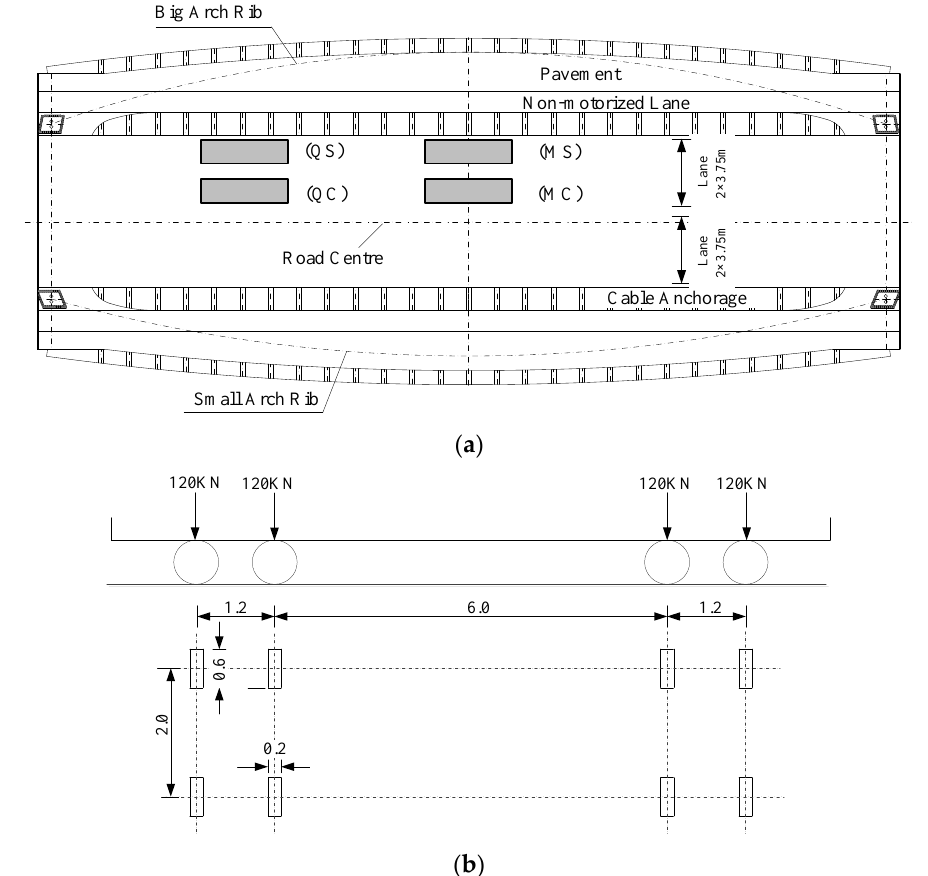
Figure 8. Load case for the global model: ( a ) load location on the deck panel; ( b ) fatigue vehicle load [35].